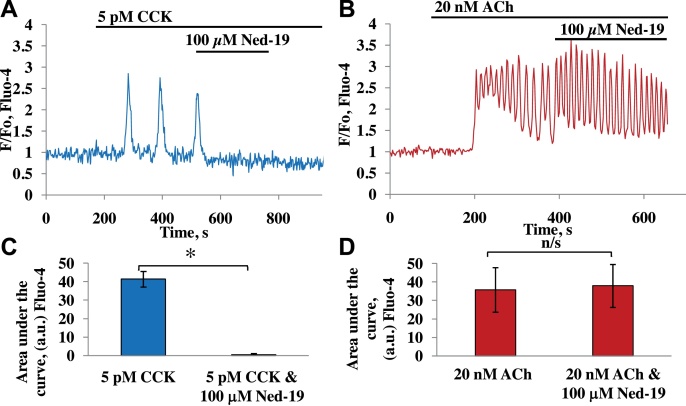
Ned-19 at high concentration (100 μM) considerably inhibited CCK responses in pancreatic acinar cells. A–B. Representative traces of responses to 5 pM CCK (A) or 20 nM ACh (B) followed by application of 100 μM Ned-19 in the continuous presence of CCK (A, n = 9) or ACh (B, n = 14). C–D. Quantification of the area under the curve (during 400 s from the addition point of 5 pM CCK or 100 μM Ned-19) in the experiments shown in A and B (41.3 ± 4.2 a.u. for 5 pM CCK and 0.5 ± 0.6 a.u. for 5 pM CCK and 100 μM Ned-19). Quantification of the area under the curve for ACh and Ned-19 is shown in D: 35.7 ± 12 a.u. for 20 nM ACh and 37.9 ± 11.6 a.u. for 20 nM ACh and 100 μM Ned-19 (D)). Error bars show ± SEM. *p < 4.9*10−8; n/s-non significant p > 0.78. Cells were loaded with Fluo-4 in AM form.